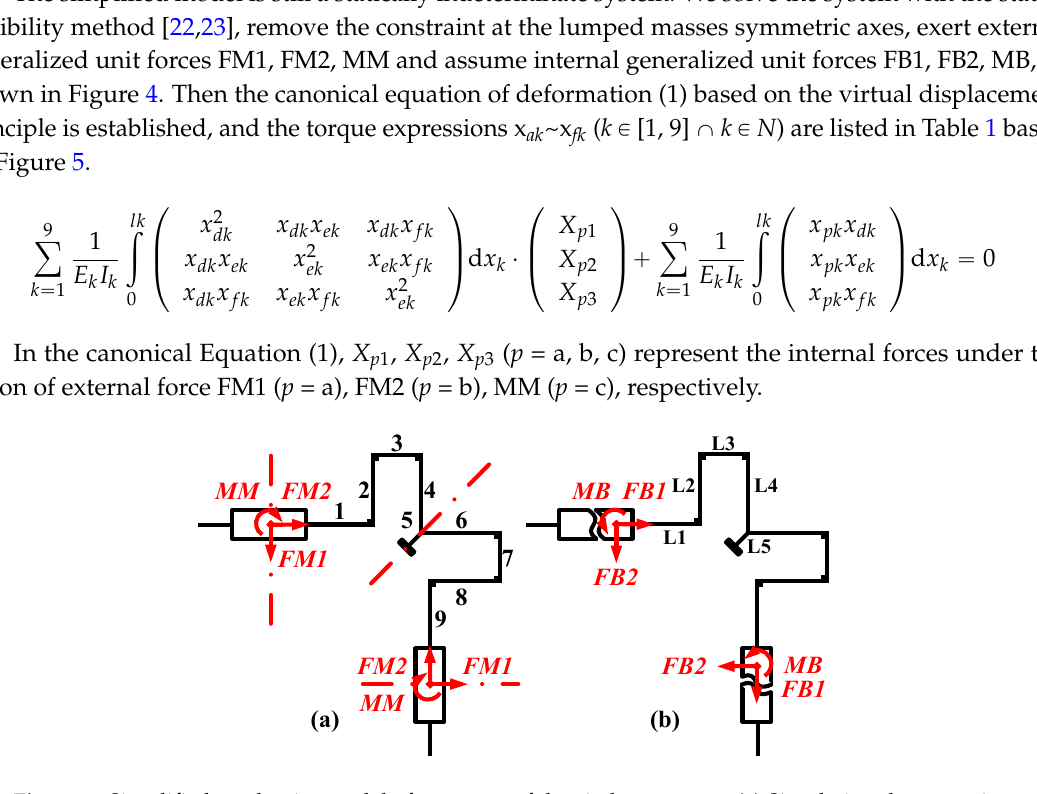
Figure 4. Simplified mechanics model of a quarter of the circle resonator. ( a ) Simulating the operation mode under external forces, and exerting external generalized unit forces FM1, FM2, MM. Numbering the microbeams from No. 1 to No. 9. Identifying the axes of symmetric position with a dotted line; ( b ) Naming the accompanied internal generalized unit forces FB1, FB2, and MB, when the circle resonator is under external forces.